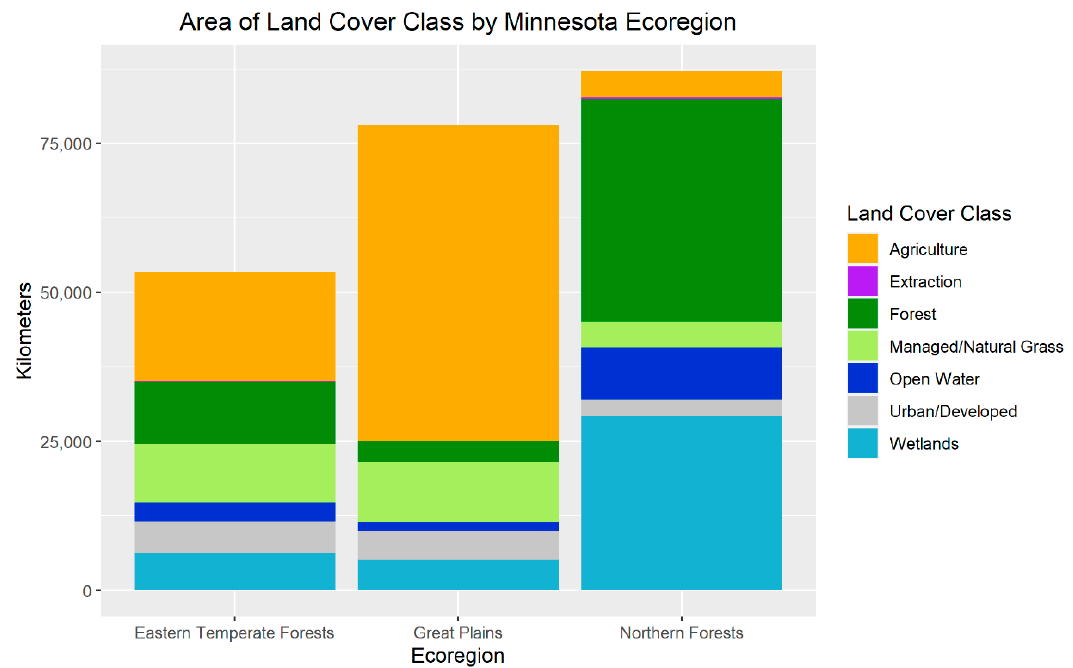
Figure 3. Area of land cover classes in Minnesota by ecoregion from the 2013–2014 land cover and impervious surface dataset for Minnesota [44]. All three of the EPA Level 1 Ecoregions in Minnesota contain significant areas of wetlands to identify, but their landscape contexts are very different. The Eastern Temperate Forests ecoregion contains a relatively even mixture of wetland, agriculture, forest, and grass. The Great Plains ecoregion contains the lowest absolute area of wetlands as many have been drained for the large area of agricultural cultivation in the region. The Northern Forests ecoregion contains the greatest area of wetlands and open water, but is also highly forested, which complicates the detection of wetlands from satellite